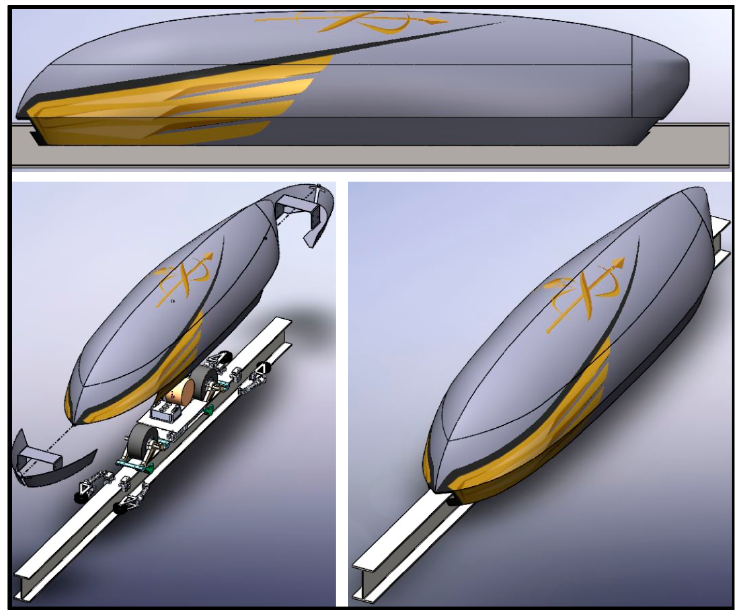
Figure 2. The modular aeroshell design of the Spartan Hyperloop competition team. The design uses a modular concept to account for the design for manufacturability and assembly considerations.